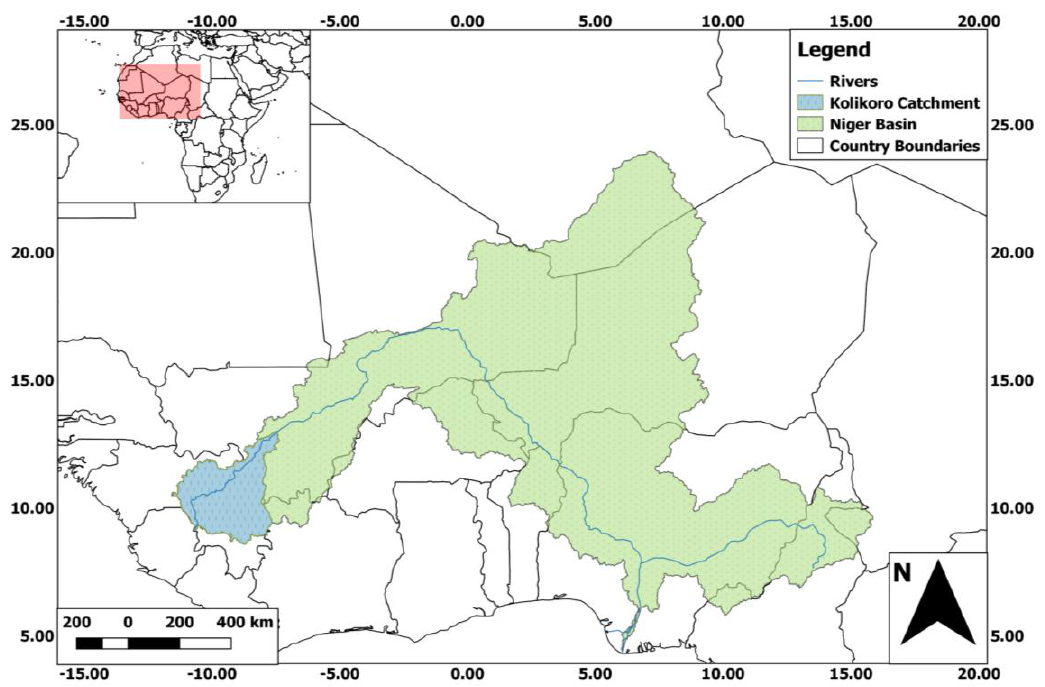
Figure 1. Location of the Koulikoro catchment in the Niger basin.